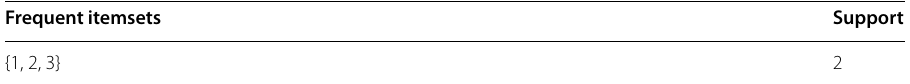
Table 7 Frequent itemsets from transaction partition 1 Frequent itemsets